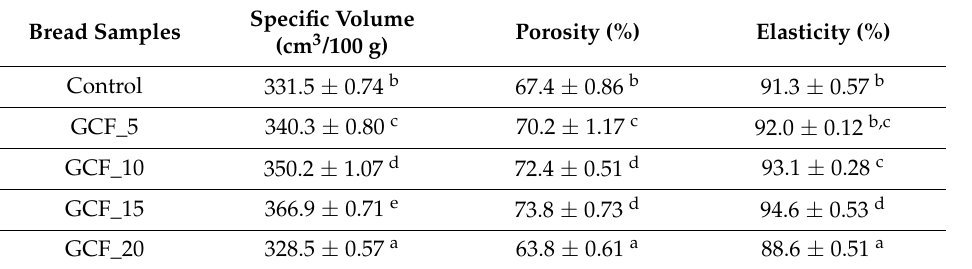
Table 4. Physical data of bread samples with different levels of GCF addition in wheat flour.